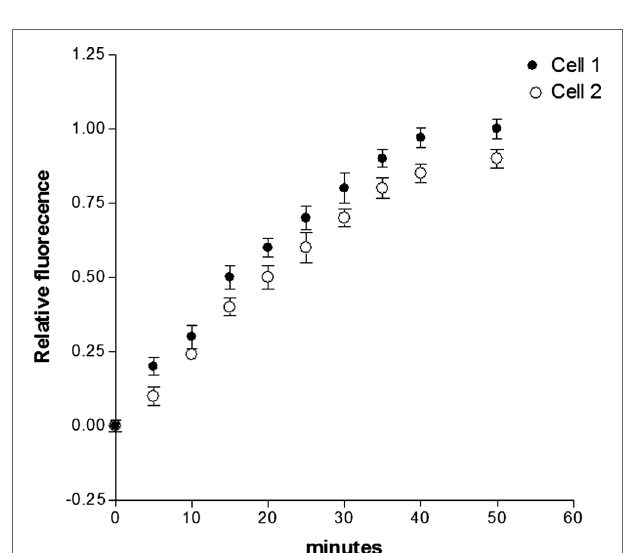
FigUre 7 | influence of PKc inhibition on the effect of aldosterone on junctional permability to glucose . Cell pairs were exposed to aldosterone (100 nM) plus Bis-1 (10 − 9 M) for 24 h and cell-to-cell diffusion of glucose was investigated. Each point is the average from 23 cell pairs (3 animals). Vertical line at each point SEM ( P < 0.05).